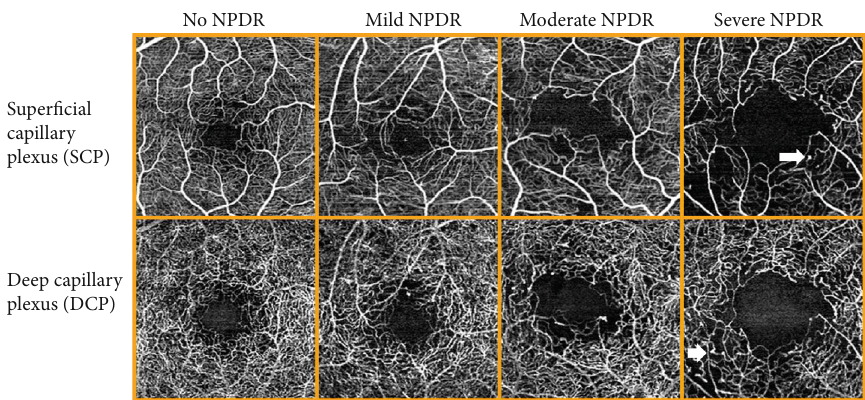
Figure 2: Representative 3 × 3 mm macular OCTA scans of the SCP and DCP for each ICDR level of NPDR in T1D patients. It is visible that the FAZ area increases and the vessel density decreases due to capillary dropout with the increasing level of NPDR. There are also some visible microaneurisms Table 2. After ICDR grading, there were 239 eyes with no DR